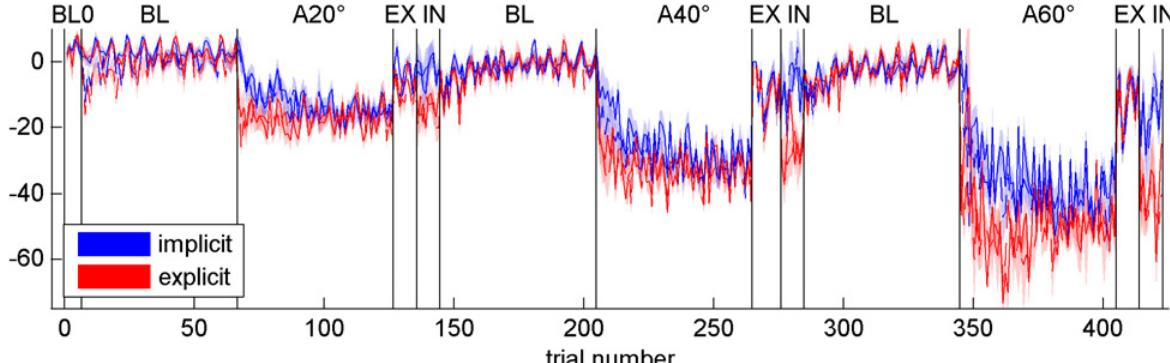
Fig 2. Movement directions of all trials. Shown are movement directions with respect to target direction of implicit (blue) and explicit (red) participants for all experimental phases. Symbols indicate across-subject means, and the shaded area display standard errors. Note that rotation size order was randomised between participants.